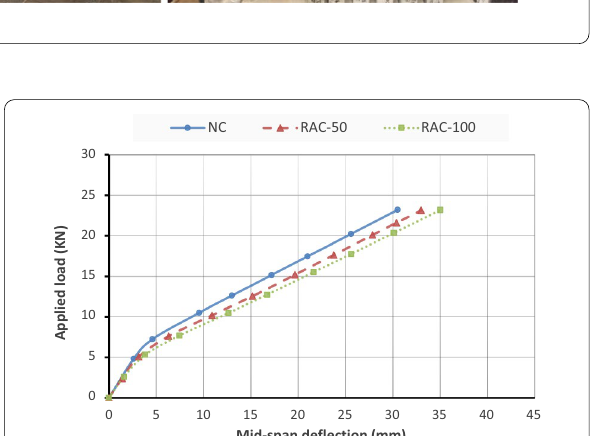
Fig. 7 Short-term deflection